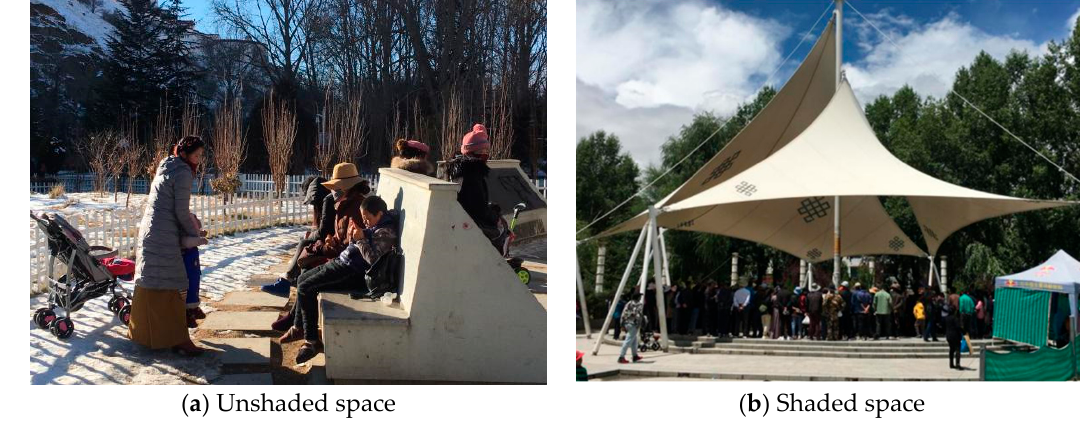
Figure 3. Outdoor environmental conditions of the Lhasa residential area.